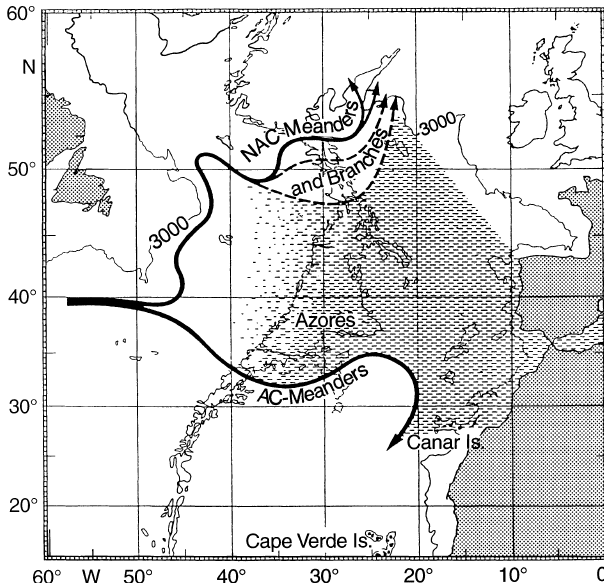
Fig. 1. Schematic ocean surface circulation in the Northeast Atlantic after Sy (1988). Shading corresponds to the extension of the Mediterranean